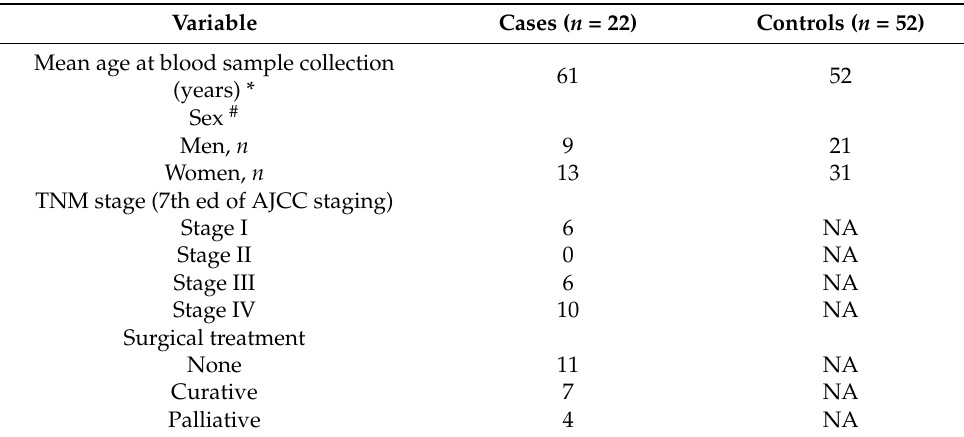
Table 2. Clinical characteristics of diagnostic